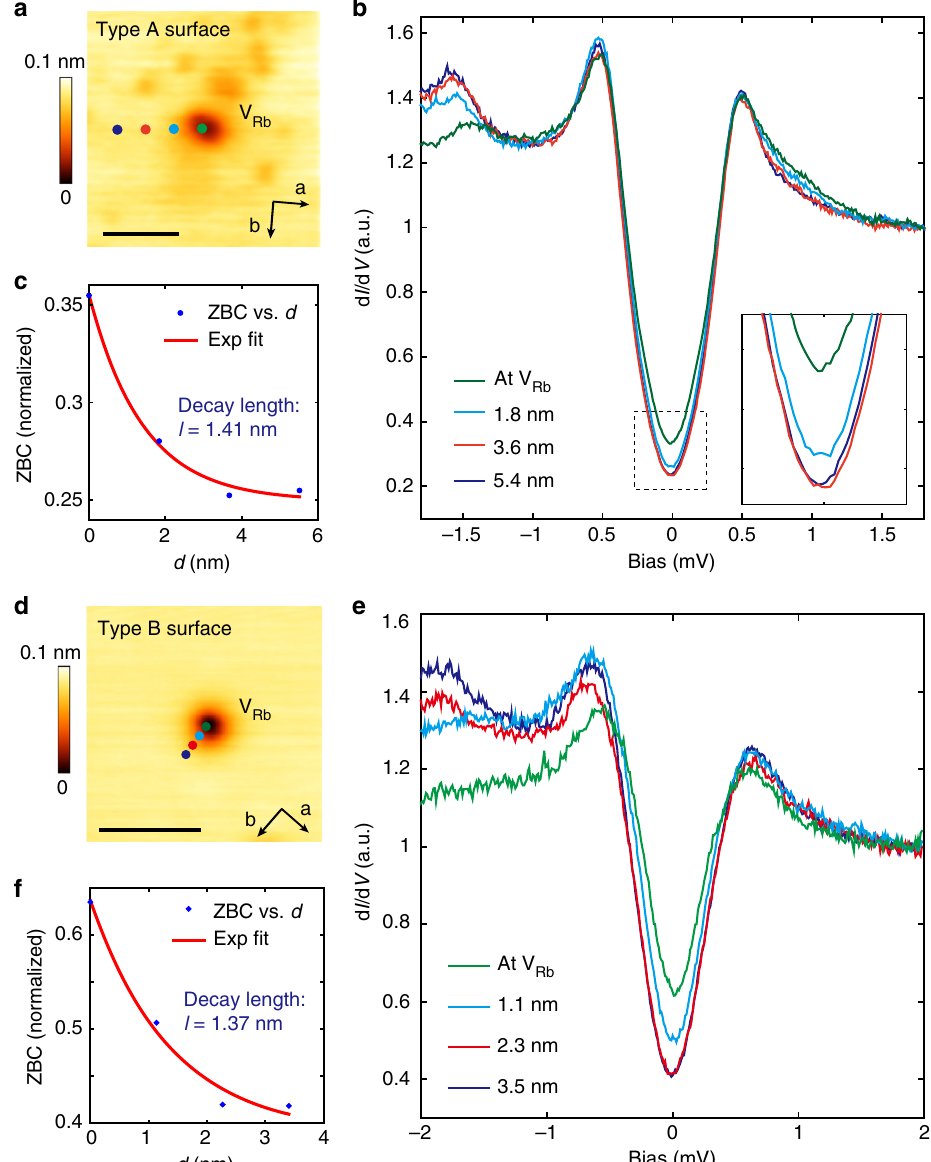
Fig. 4 Effect of a surface defect (V Rb ) on superconductivity. a Topographic image of a surface Rb vacancy (V Rb ) on type A surface ( V b = 30 mV, I = 10 pA; scale bar: 5 nm). b d I /d V spectra taken at various distances from V Rb ( V b = 1.8 mV, I = 100 pA, Δ V = 50 μ V, T eff = 310 mK), the tip positions are marked in panel a . Inset displays the gap bottom showing the suppression of the gap. c ZBC value of the gap bottom as function of distance from V Rb ; the red curve is an exponential fi t, which yields a decay length of 1.41 nm. d Topographic image of a Rb vacancy on type B surface ( V b = 1.0 V, I = 10 pA; scale bar: 5 nm). e d I /d V spectra taken at various distances from V Rb ( V b = 2 mV, I = 100 pA, Δ V = 50 μ V, T eff = 310 mK), the tip positions are marked in panel d . f ZBC value as function of distance from V Rb ; red curve is an exponential fi t which yields a decay length of 1.37